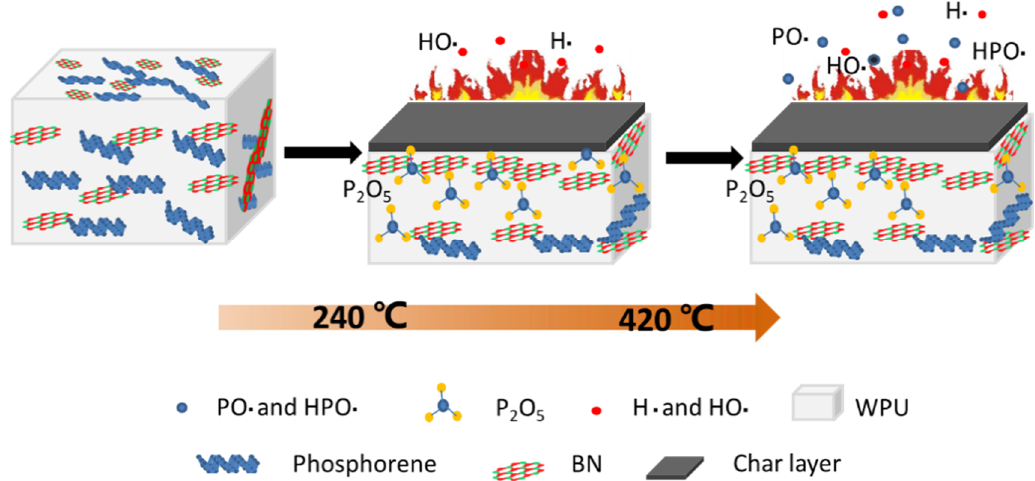
Figure 8. Schematic illustration of the flame-retardant mechanism.